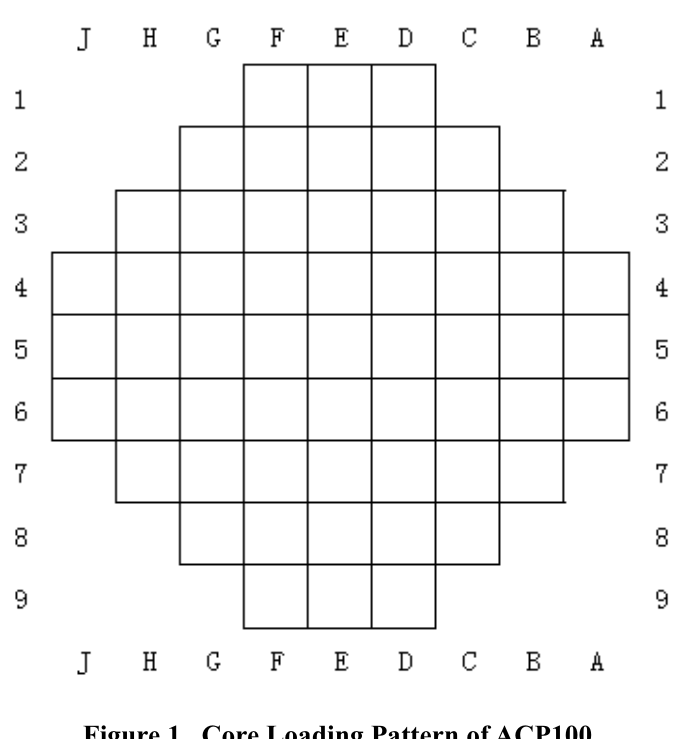
Figure 1. Core Loading Pattern of